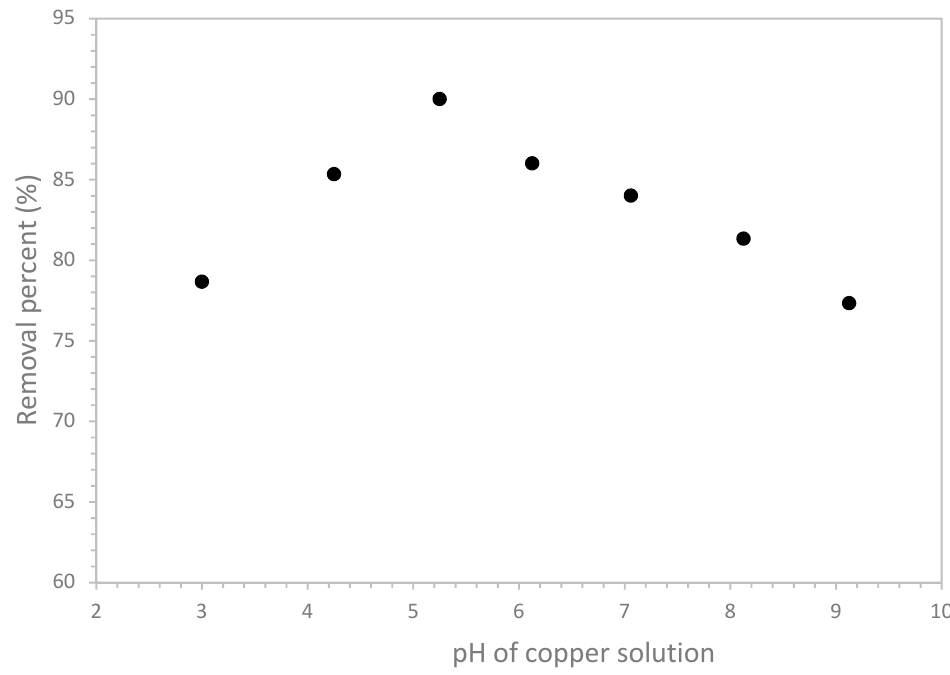
Figure 5. Effect of pH on copper removal from aqueous solution by olive oil pomace.